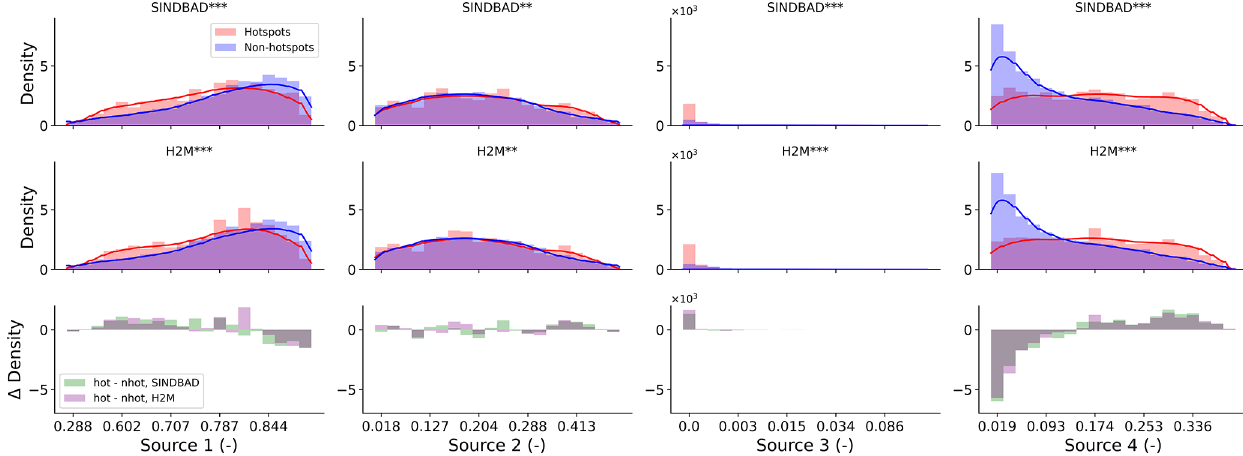
Figure 8. Same as Fig. 7 but for the contribution of four water sources to the water usage by vegetation. Data by Miguez-Macho and Fan (2021) were used for the four sources. Source 1 is soil water from recent ( < 1 month) precipitation, source 2 is soil water from past precipitation, source 3 is locally recharged groundwater via capillary flow, and source 4 is remotely recharged groundwater from uplands to